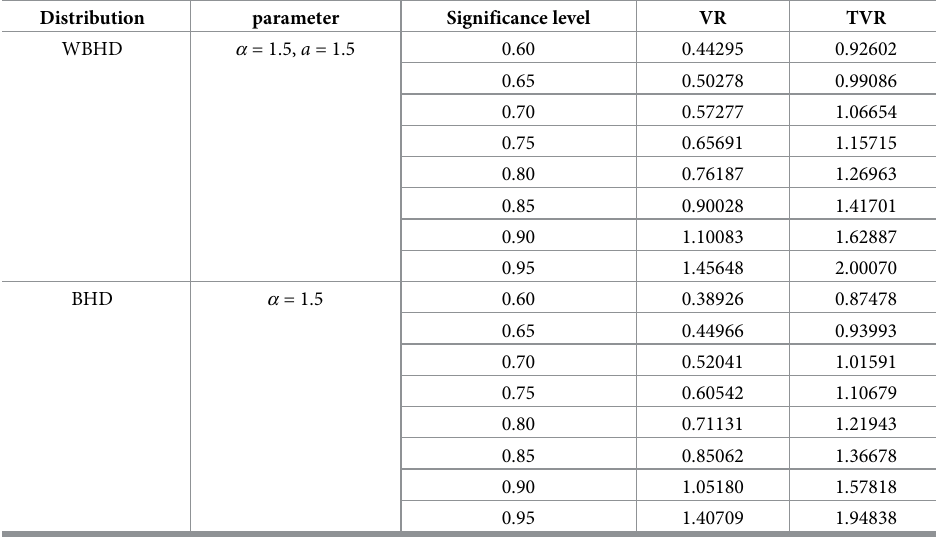
Table 8. Numerical results of VR and TVR for the WBHD and